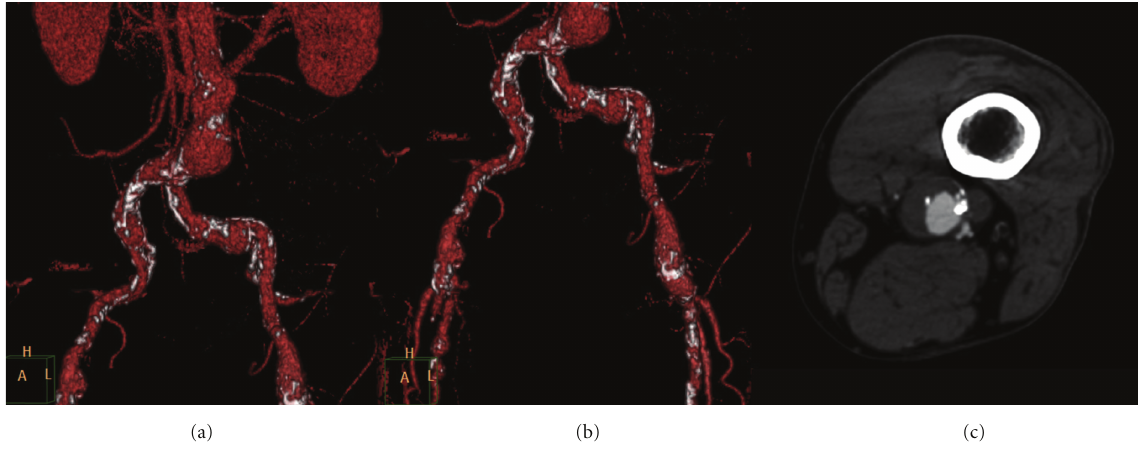
Figure 1: Three-dimensional reconstruction of computed tomography angiography illustrating the infrarenal abdominal aortic aneurysm (a) and aneurysms of both common femoral arteries (b). CT axial image revealing the aneurysm of the left popliteal artery